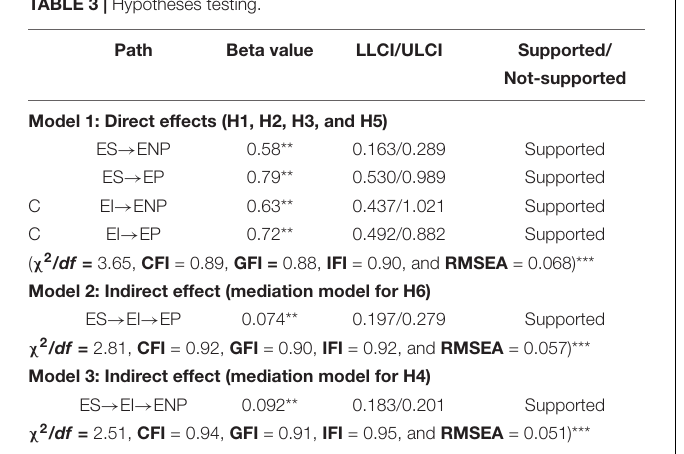
FIGURE 1 | Proposed research model: ES (X), the independent variable; ENP (Yi), the dependent variable; EP (Y2), the dependent variable; EI (M), the mediating variable; C’, direct effect of X on Y1 with the effect of the mediator (M); e’, direct effect of X on Y2 with the effect of the mediator (M); C, direct effect of X on Y1 without mediator; e, direct effect of X on Y2 with